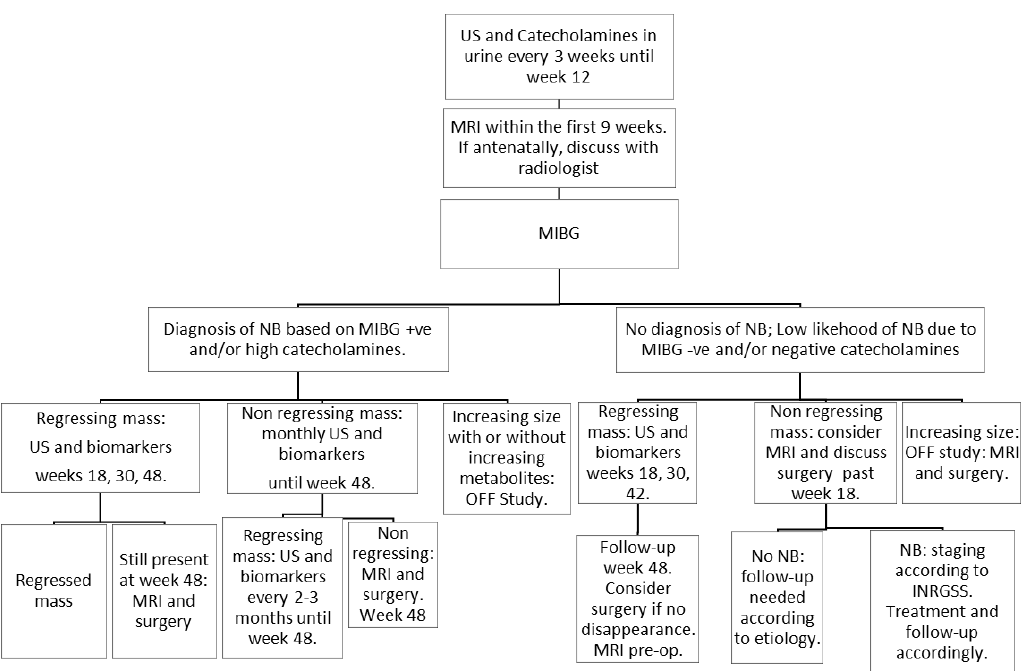
Figure 1. Therapeutic management of suprarenal masses with follow-up investigations at prescribed intervals during the observational course of the